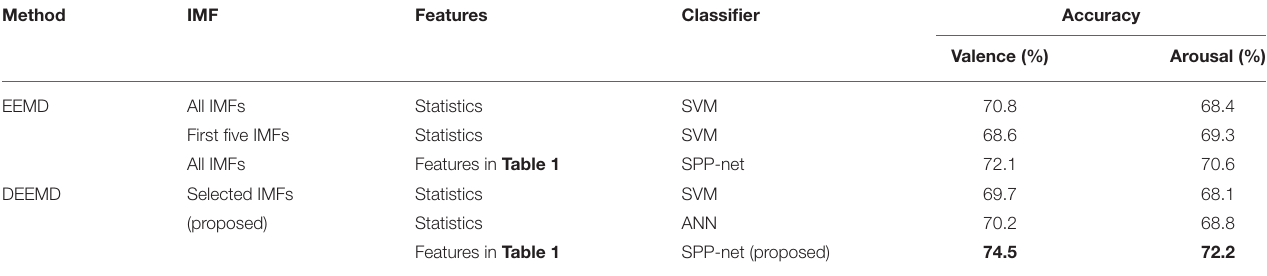
TABLE 3 | The classification accuracies of valence and